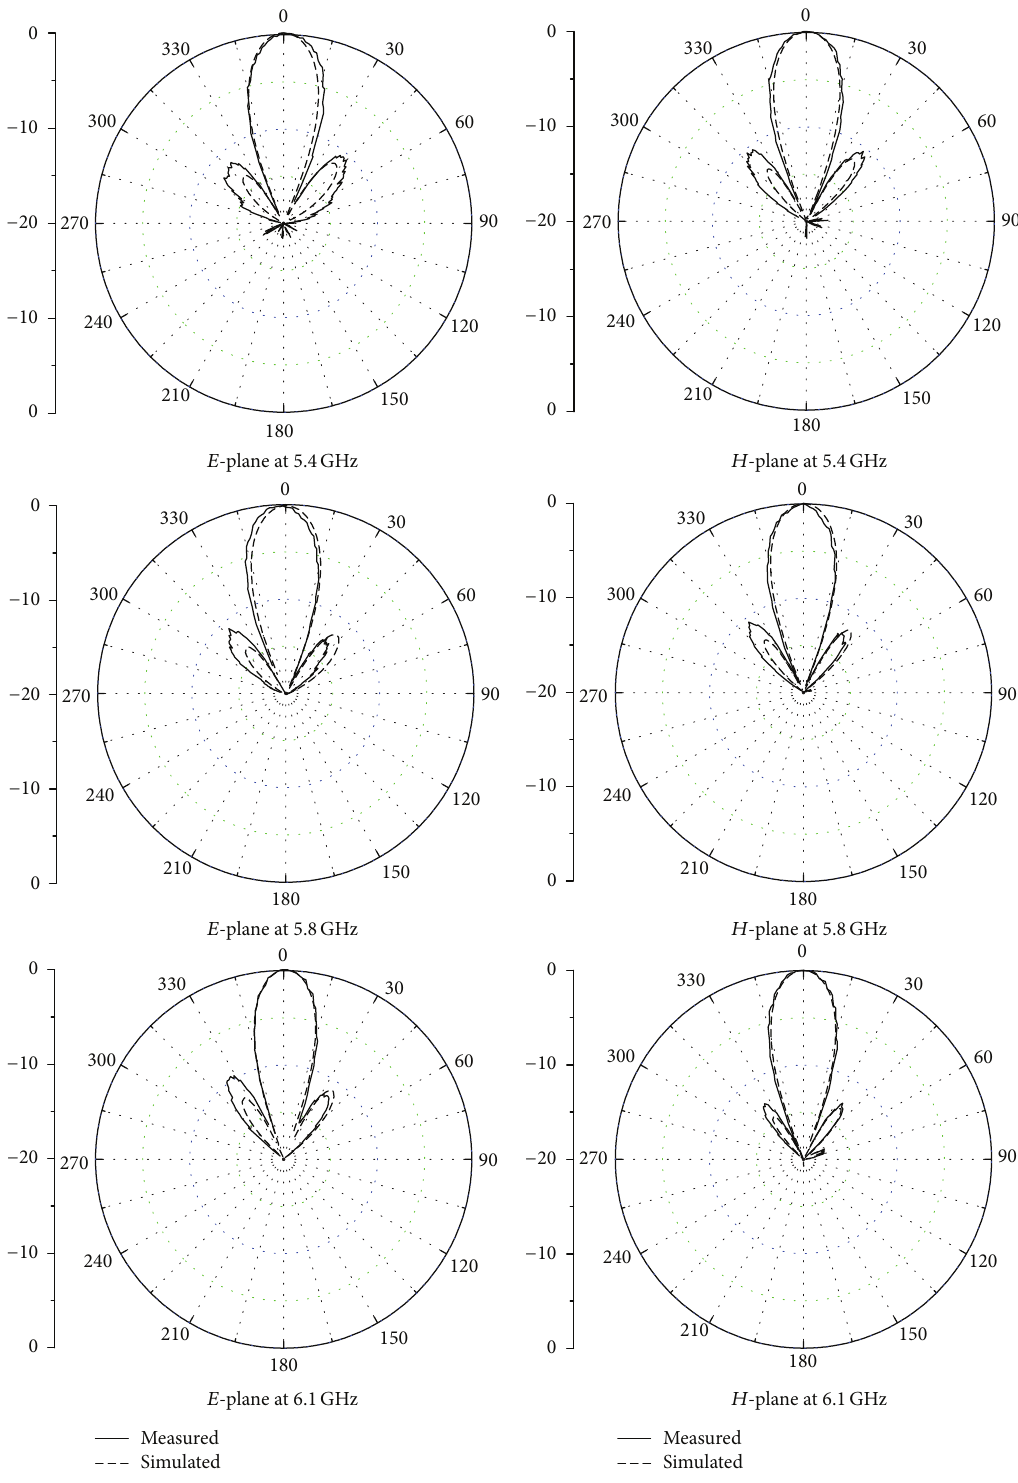
Figure 16: Measured and simulated radiation patterns on the 𝐸 -plane and the 𝐻 -plane at different frequencies of the 4 × 4 fractal antenna